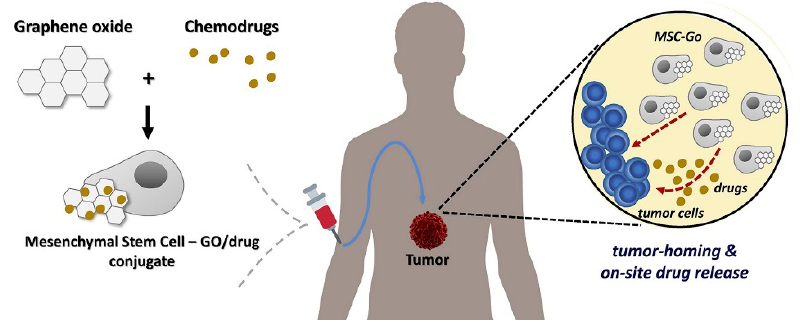
Figure 3. Schematic representation of GO as a competent drug nanocarrier on MSCs for cancer therapy [74].